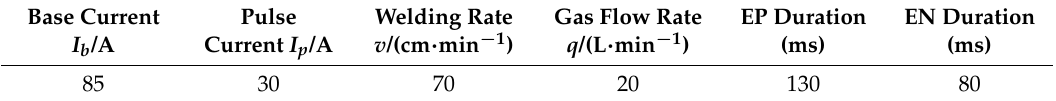
Figure 1. The experiment installation of AC CMT coupled with ultrahigh-frequency power supply ( a ) and the schematic of the AC CMT current waveform ( b ). Table 1. Process parameters of UHF-ACCMT welding.